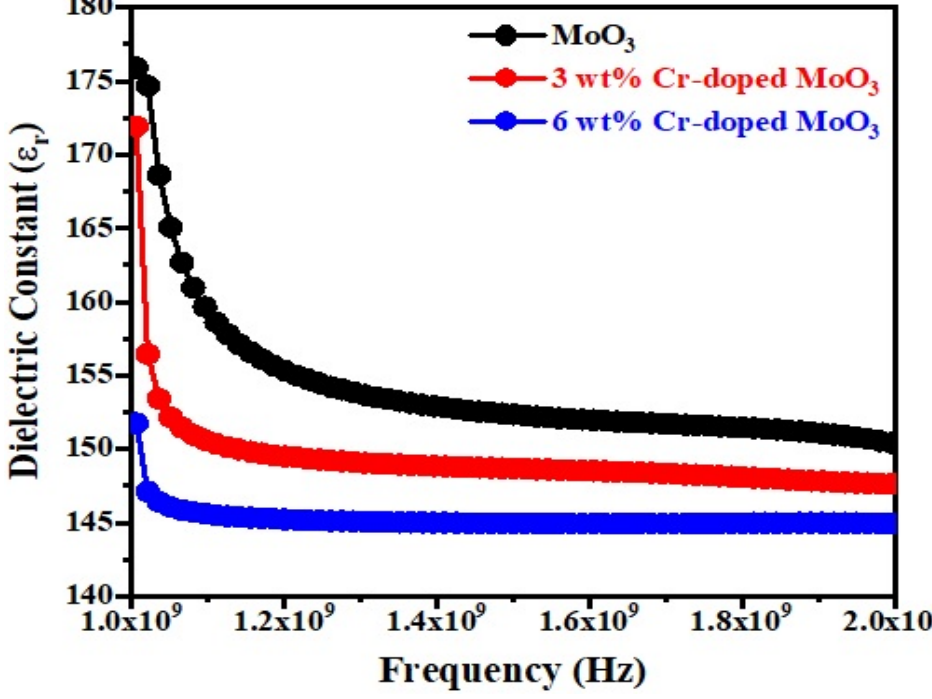
Figure 7. Dielectric constant as a function of frequency of un-doped and Cr-doped MoO 3.